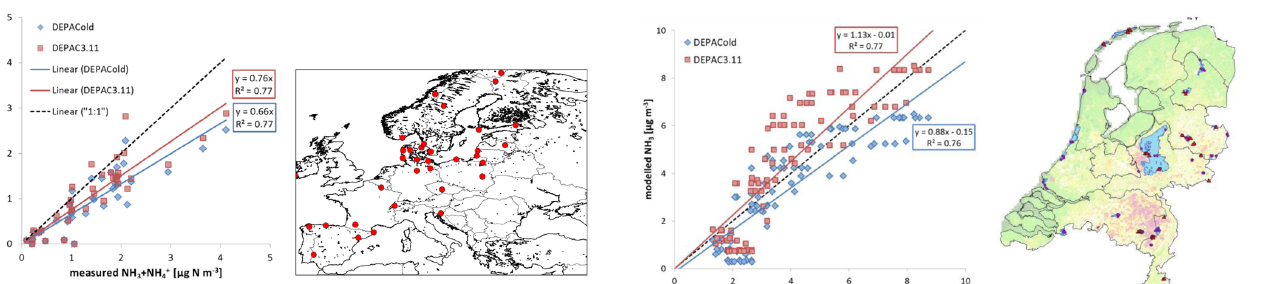
Fig. 9. Model comparison of annual mean ammonia concentrations modeled with LOTOS-EUROS using the two surface–atmosphere exchange modules and measurements of the Monitoring network of Ammonia in Nature areas larger than 500ha in the Netherlands in 2007 (Stolk et al., 2009). The grid resolution of the model results is 0.125 ◦ longitude × 0.0625 ◦ latitude ( ∼ 7 × 7km 2 )